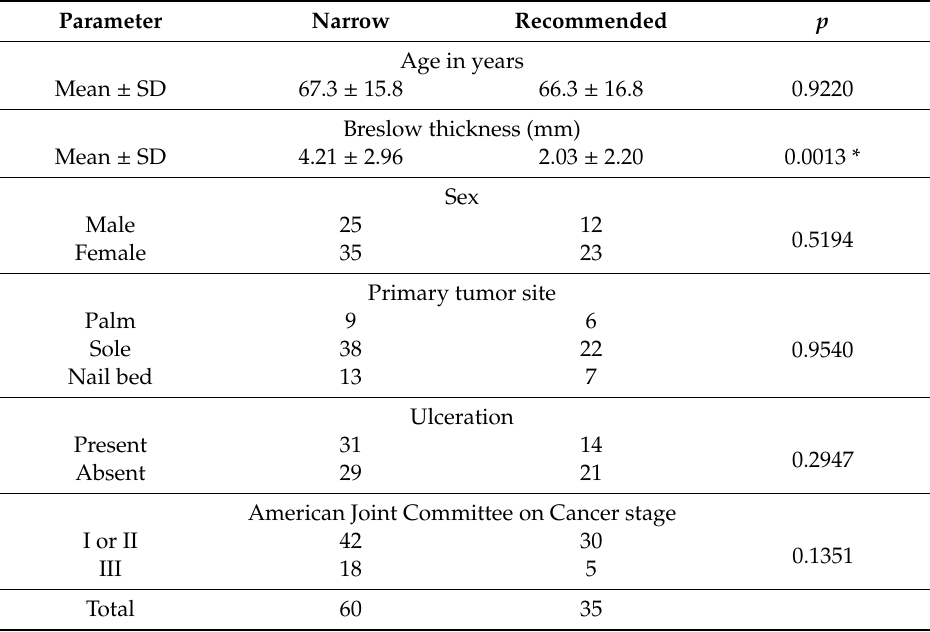
Table 4. Comparison between narrow and recommended margins for stage I–III